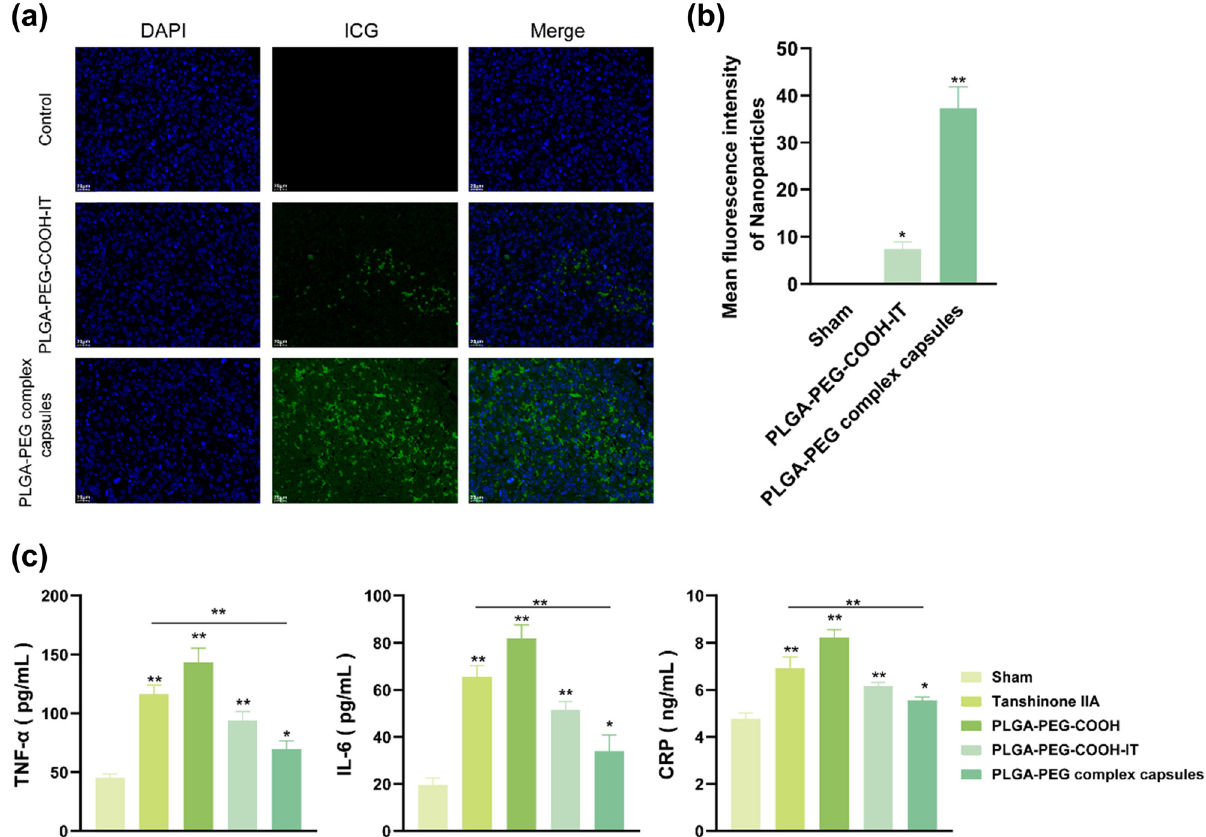
Figure 5: Distribution of nanoparticles and in fl ammatory response in brain tissues of the MCAO model. ( a and b ) Fluorescence distribution and intensity statistics ( n = 3, * P < 0.05, ** P < 0.01 ) of composite nanocapsules in the ischemic brain sections ( DAPI blue fl uorescence: cell nuclei; FITC green fl uorescence: nanoparticle; scale: 20 μ m ) . ( c ) The levels of TNF - α , IL - 6, and CRP in the ischemic brain sections were detected by ELISA ( n = 3 )